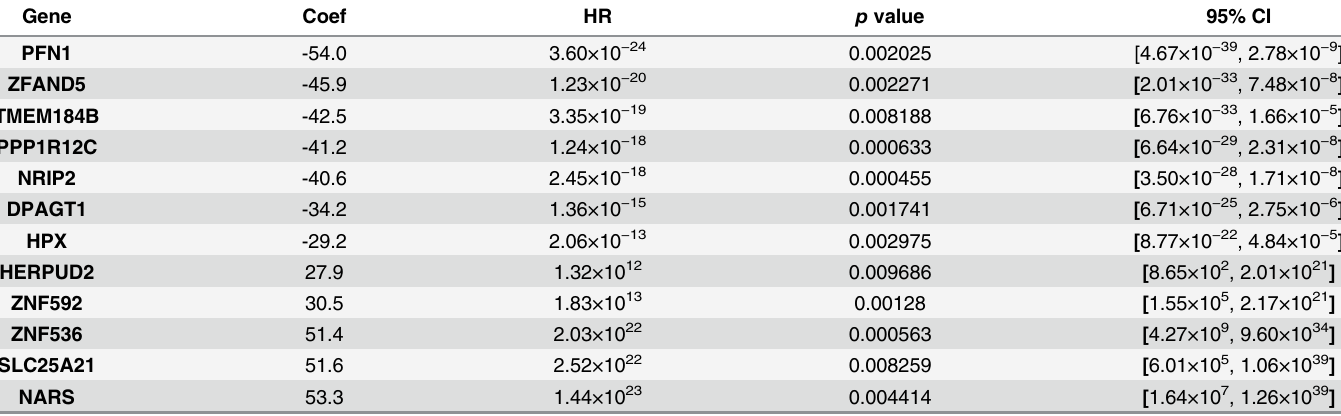
Abbreviations: Coef is the Cox proportional hazard model regression coef fi cient. HR: hazard ratio; CI: con fi dence interval; p value: cox regression model p